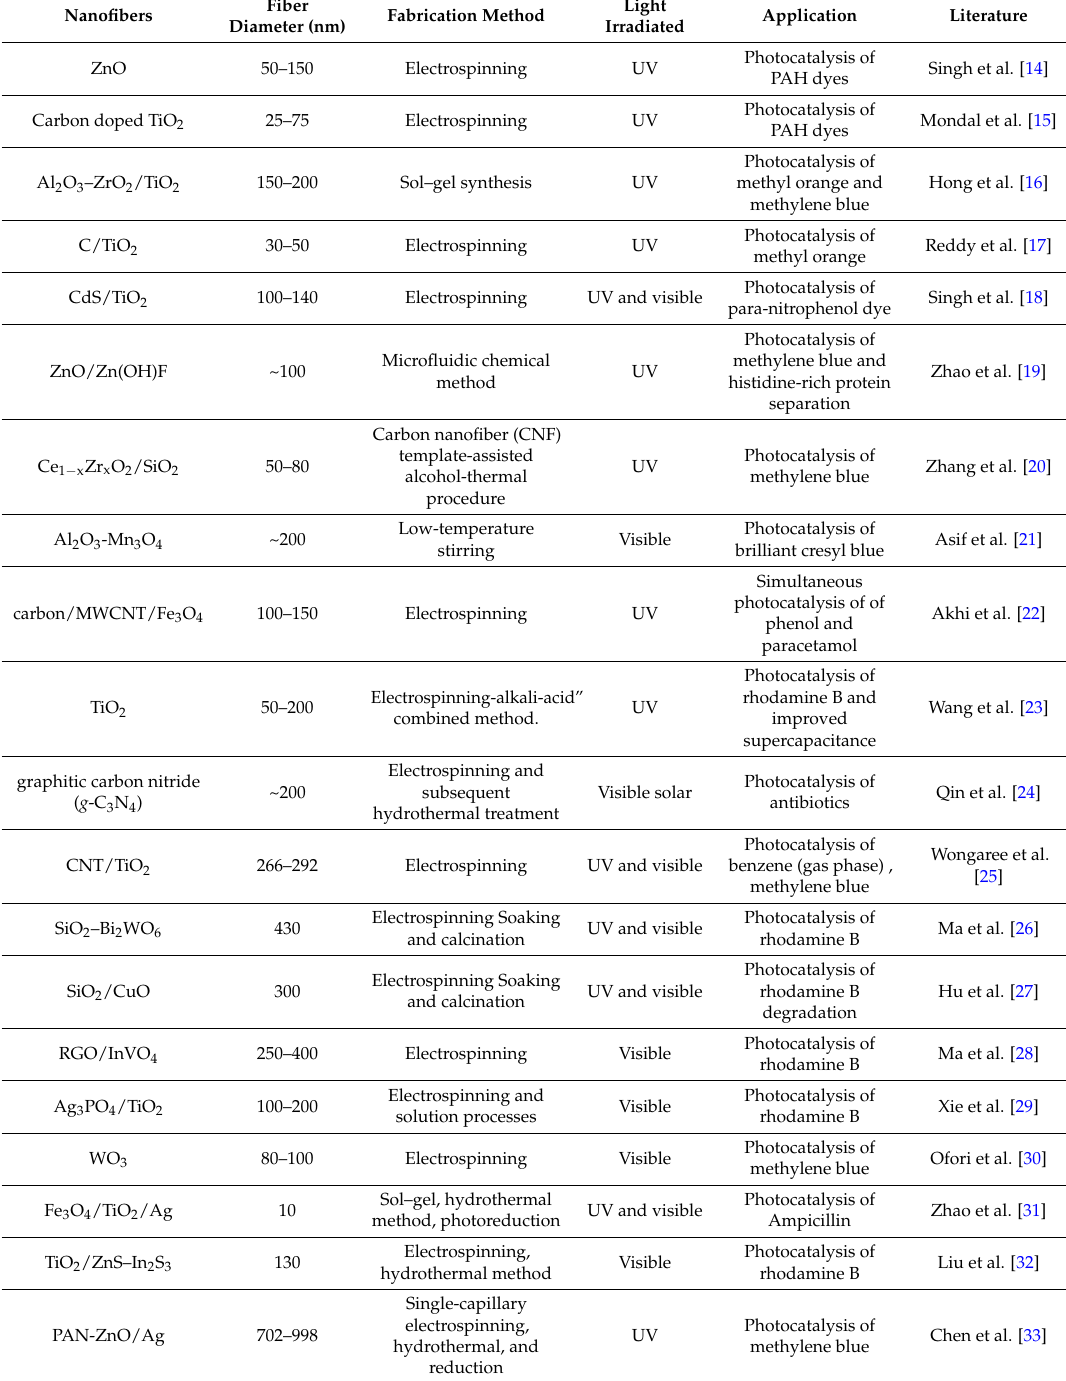
Table 1. Table of metal oxide nanofiber photocatalysts and their environmental remediation